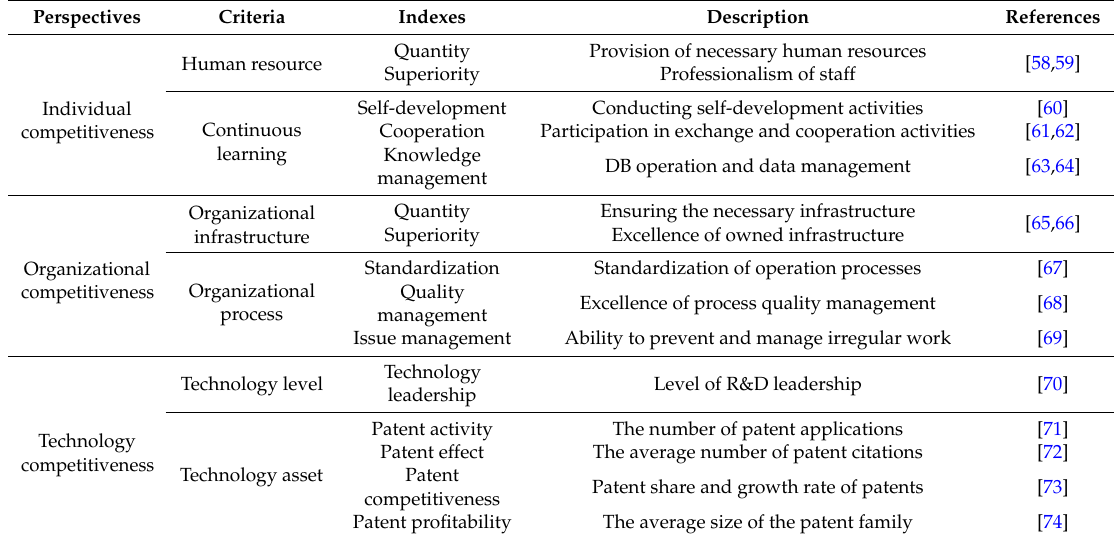
Table 1. Evaluation areas, criteria, and indexes for evaluating technological